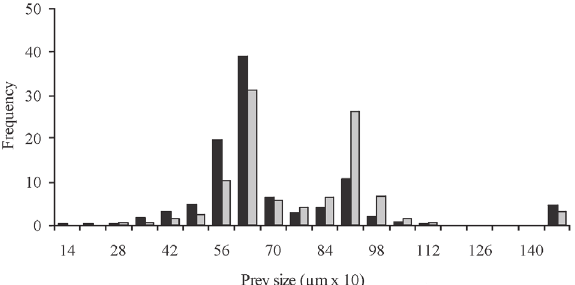
Fig. 7 . – Length frequency distribution of prey in the stomach content of A. minuta . small fish ( ≤ 43 mm tL) ( n ); large fish (>43 mm tL) ( n